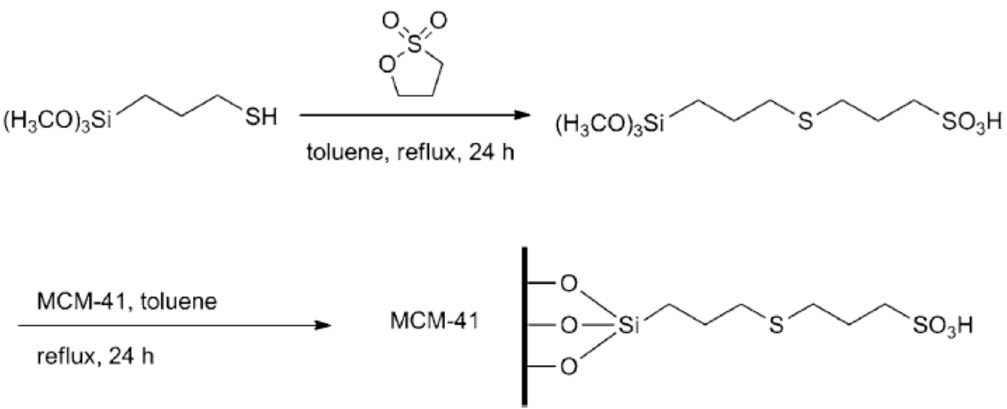
Figure 10. Synthesis of dihydro-1 H -pyrazolo[3,4- b ]pyridines and 1 H -pyrazolo[3,4- b ]pyridines